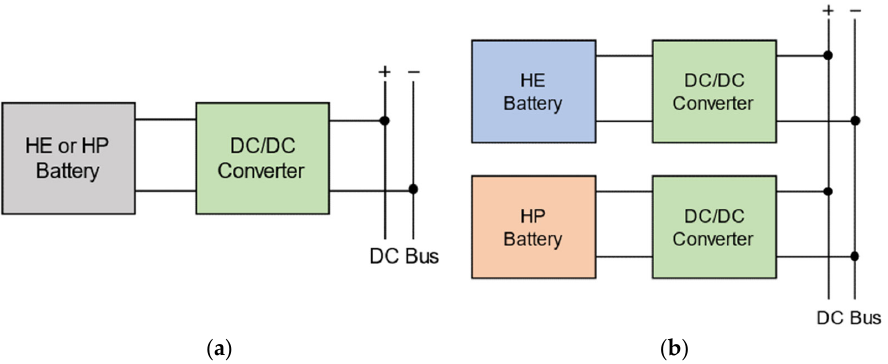
Figure 3. Schematic of battery system topologies: ( a ) monotype, ( b ) HESS topology.